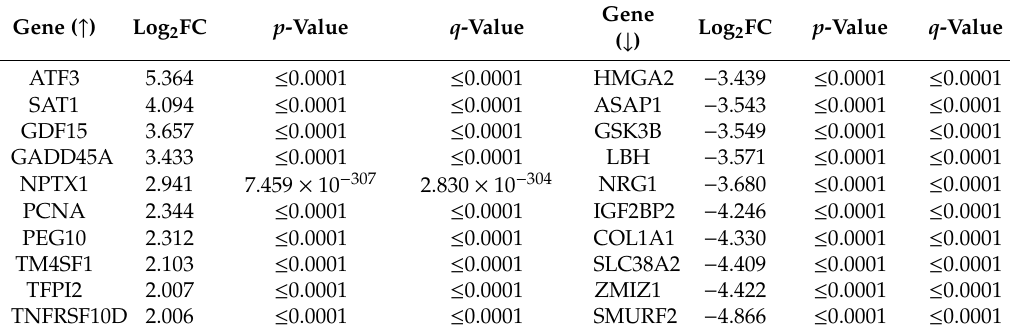
Table 3. Phenanthriplatin and cisplatin modulate gene regulation in IMR90 cells. Top 10 up- and downregulated DEGs for IMR90 phenanthriplatin versus IMR90 control. DEG data analysis: ( p ≤ 0.05;